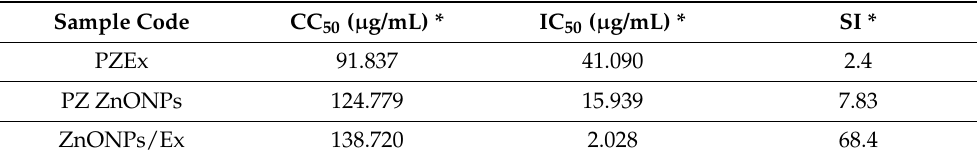
Figure 8. The cytotoxic effects (CC 50 ) and the inhibition concentration (IC 50 ) of the ( A ) PZ Ex, ( B ) PZ ZnONPs, and ( C ) PZEx/ZnONPs. Table 2. The Anti-HCoV-229E activity of P. zonale extract, ZnONPs, and their